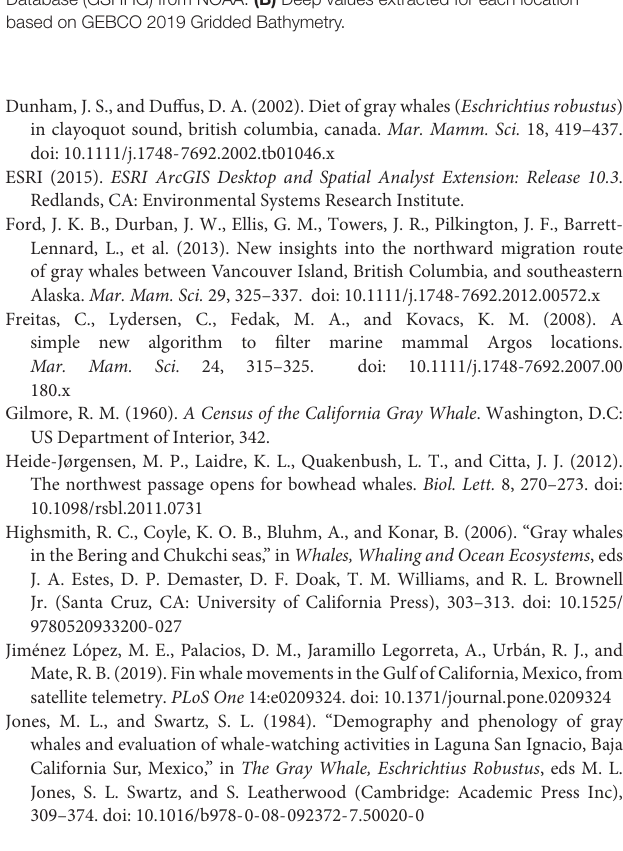
Supplementary Figure 1 | (A) Distance calculates from locations to coastline based on Global Self-consistent, Hierarchical, High-resolution Geography Database (GSHHG) from NOAA. (B) Deep values extracted for each location based on GEBCO 2019 Gridded